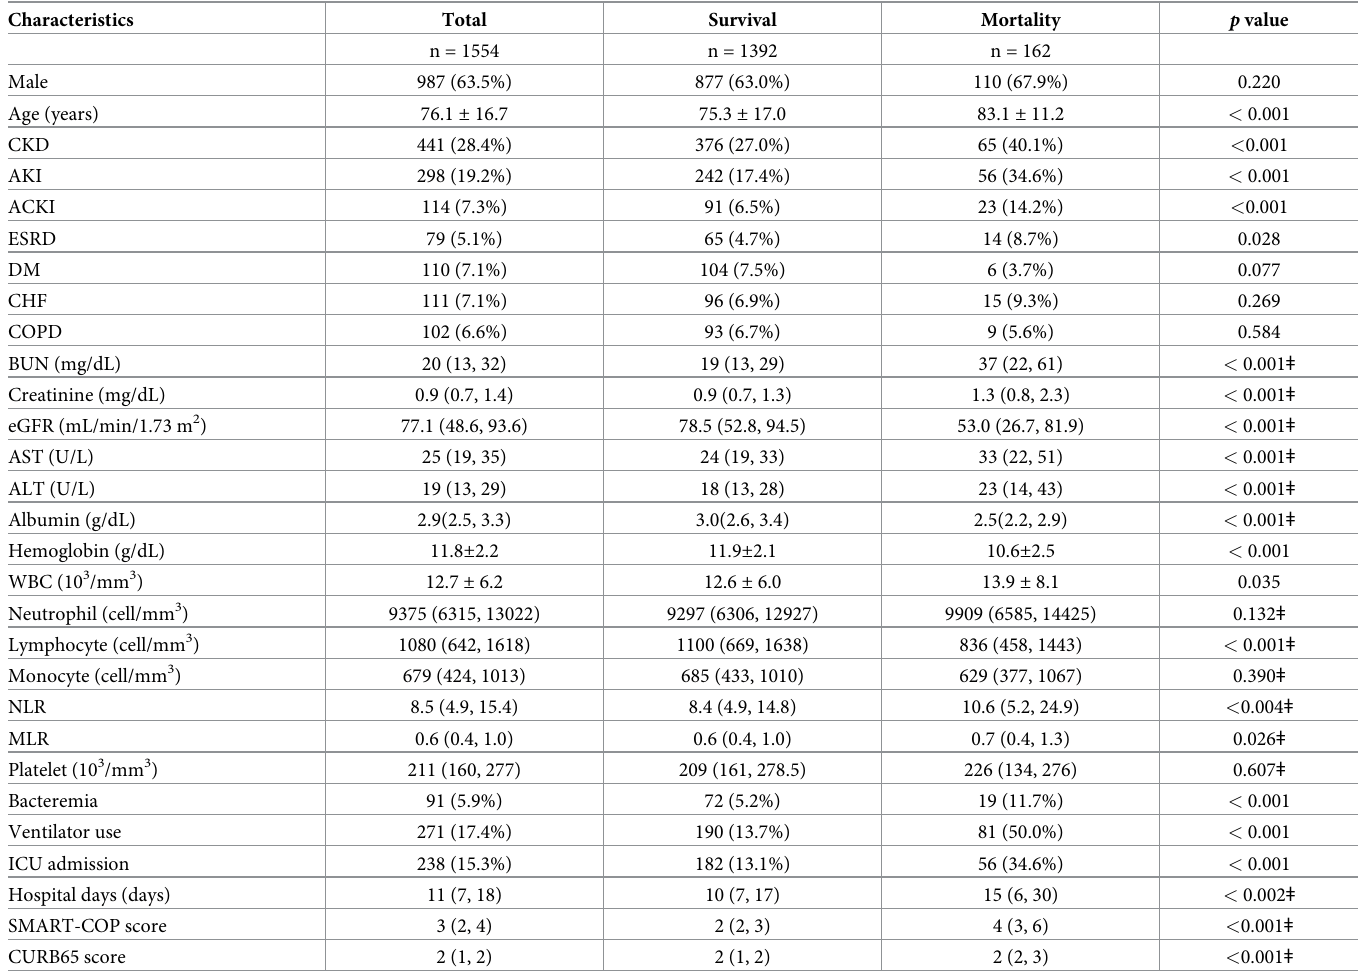
Table 1. Demographic and laboratory characteristics of patients hospitalized with pneumonia.